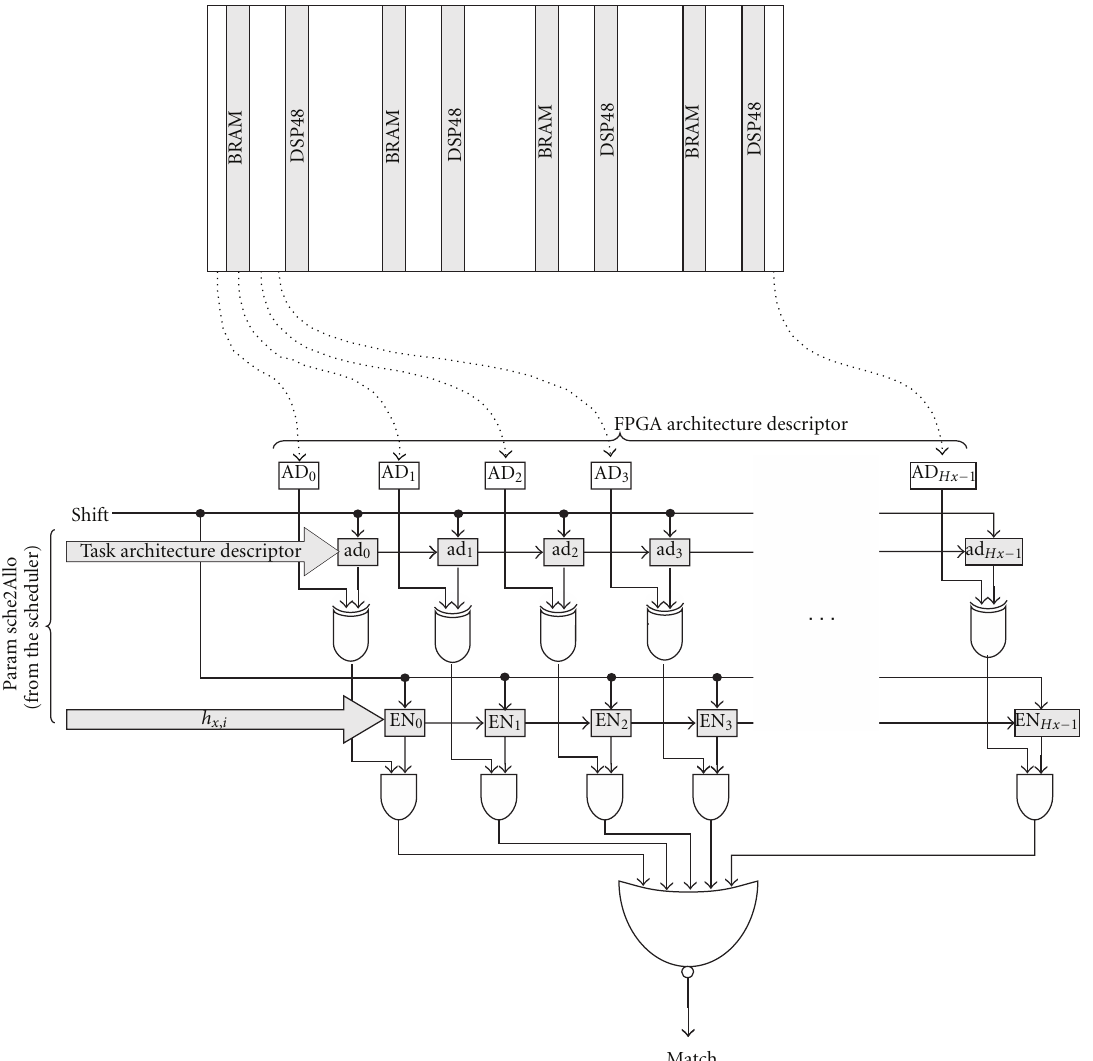
Figure 21: Simplified structure of the Architecture Checker